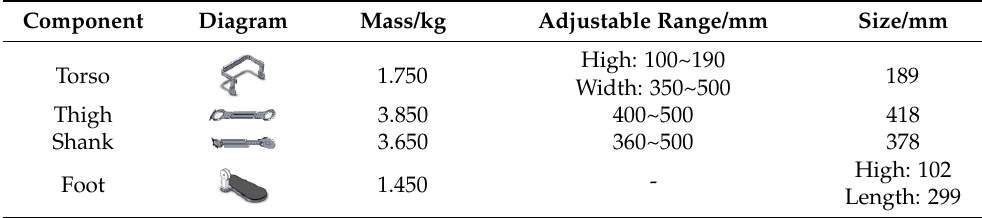
Figure 1. The prototype of the lower limb rehabilitation exoskeleton robot. Each leg of the robot has three degrees of freedom to enable flexion or extension movements of the hip joint, knee joint, and ankle joint in the sagittal plane. The flexion or extension movements of the hip and knee joints are active movements driven by motors. In contrast, the ankle joints did not have active movement capabilities. By controlling the flexion or extension movement of the hip and knee joints of the lower limb rehabilitation exoskeleton robot, auxiliary exercises can be realized for the patient. The parameters of each component of the lower limb rehabilitation exoskeleton robot are shown in Table 1. Among them, the torso can be adjusted by adjusting the distance between the connecting rods on both sides, and the thigh and the shank can be adjusted in length by adjusting the position of the assembly hole to adapt to the body characteristics of different patients. Table 1. Parameters of each component of the exoskeleton robot for lower limb rehabilitation. Component